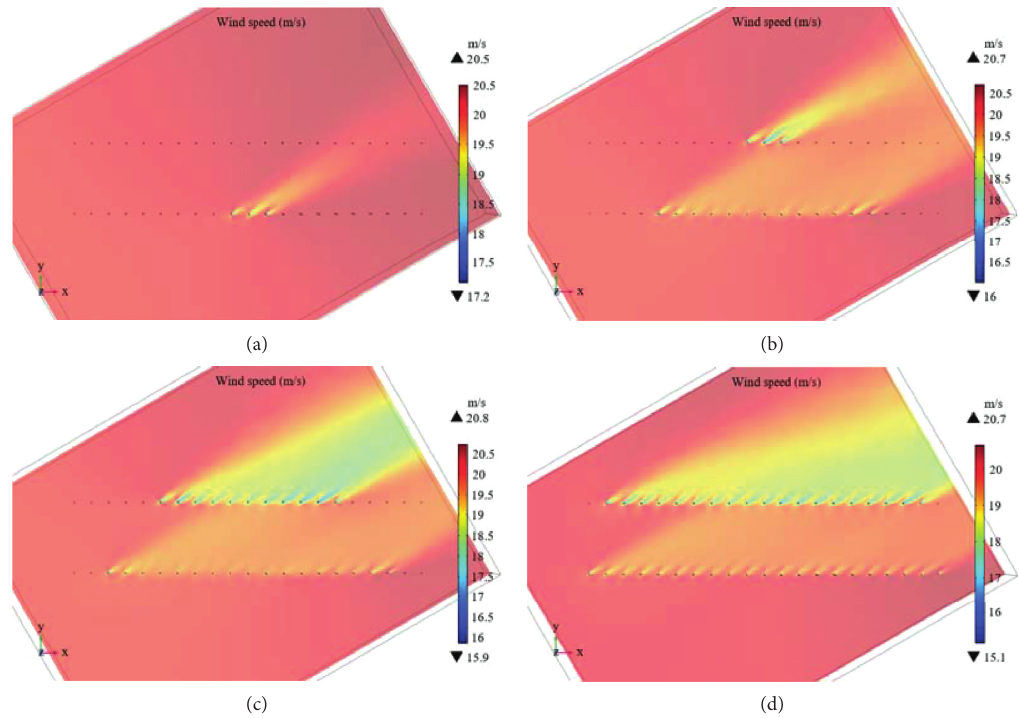
Figure 5: Influence of height for wind field (wind direction � 30 ° /120 ° ). (a) 30 ° /150 ° , z � 10m. (b) 30 ° /150 ° , z � 5m. (c) 30 ° /150 ° , z � 3m. (d) 30 ° /150 ° , z � 1